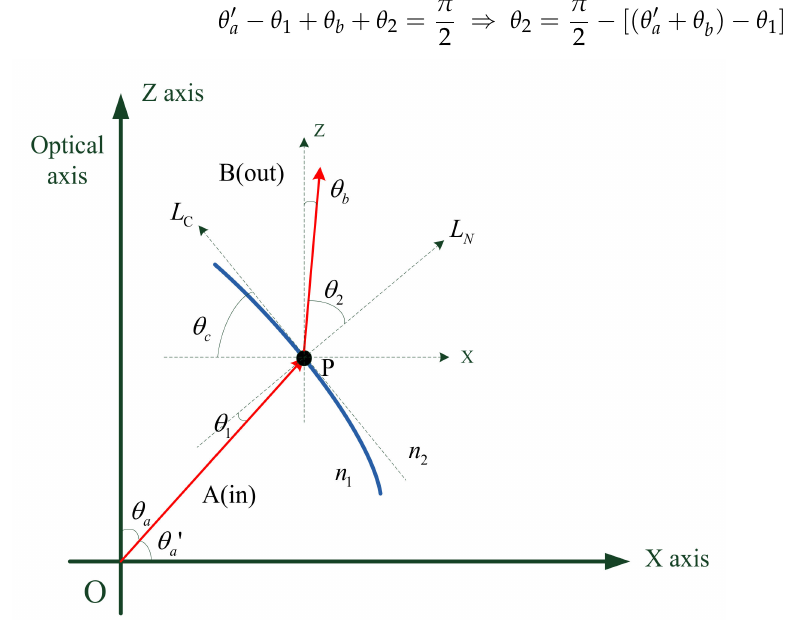
Figure 6. Geometric analysis of the curved surface